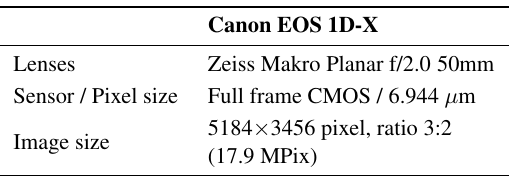
Figure 8. Iterative scheme of single projection ray intersecting